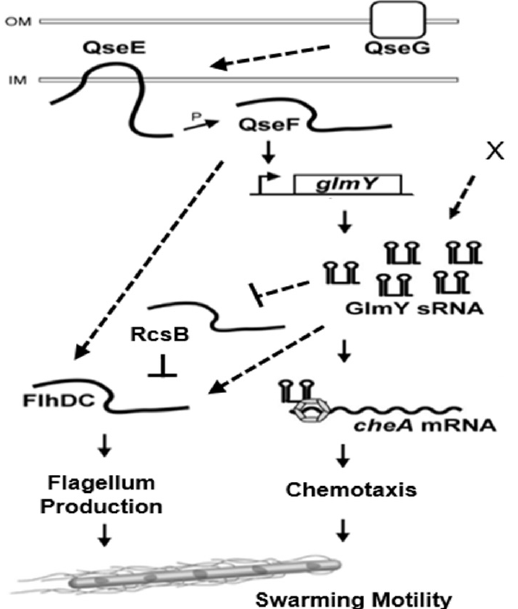
Figure 6. Summary of the swarming regulation by the QseEF-GlmY pathway involving expression of rcsB , flhDC and cheA . The sensor kinase QseE senses specific signals and transfers phosphoryl group to response regulator QseF. Then, QseF activates expression of GlmY, followed by cheA activation and rcsB inhibition. RcsB downregulation and CheA upregulation facilitate flagellum production and swarmer cell differentiation, respectively, thereby enhancing swarming motility. QseG could help activation of QseEF and unknown factor X facilitates GlmY expression. GlmY may interact with flhDC and modulate its expression. In addition, QseF could affect flhDC expression in a GlmY-independent way. Arrow, positive effect; line with a vertical bar, negative effect; dotted line, direct effect needed to be investigated.